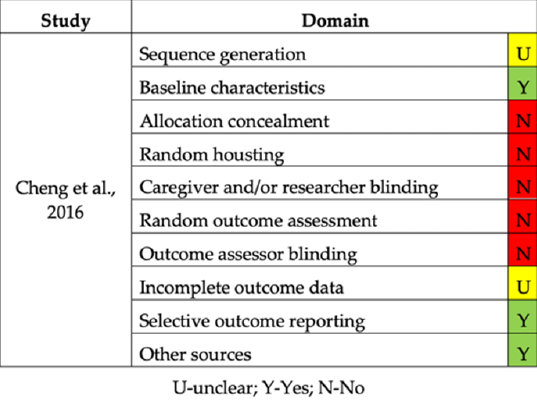
Figure 3. Risk of bias of the in vivo study .